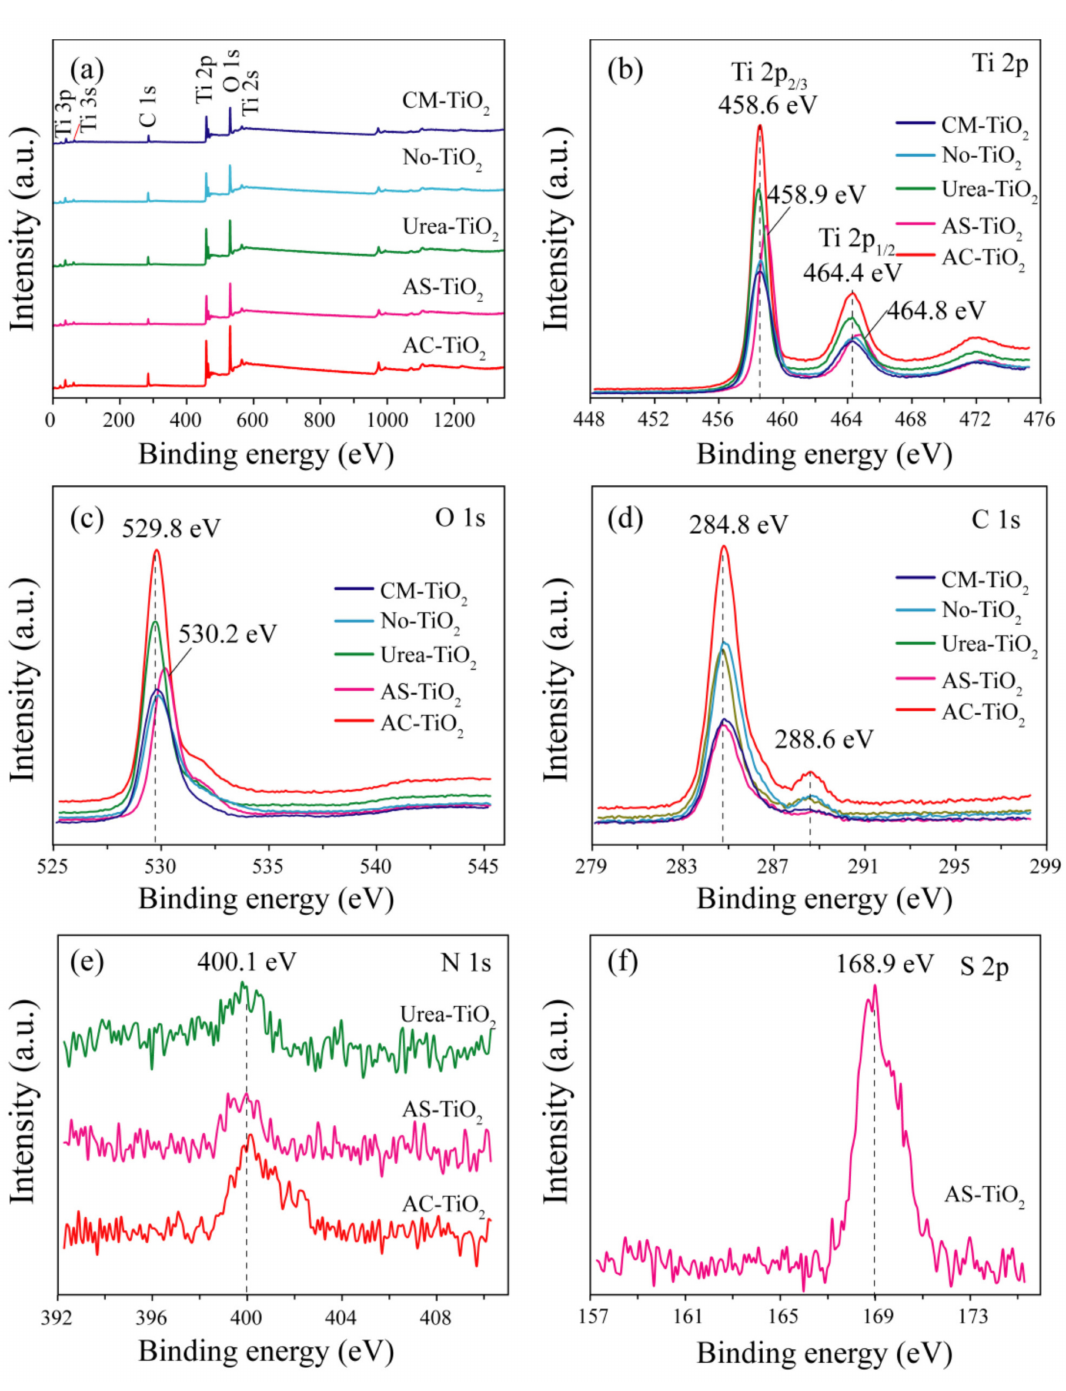
Figure 4. XPS spectra of AC-TiO 2 , AS-TiO 2 , urea-TiO 2 , No-TiO 2 , and CM-TiO 2 : ( a ) survey spectra; ( b ) Ti 2p spectra; ( c ) O 1s spectra; ( d ) C 1s spectra; ( e ) N 1s spectra; ( f ) S 2p